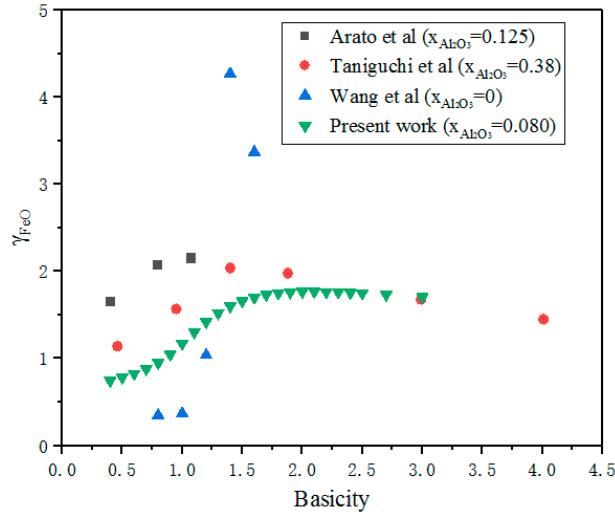
Figure 5. Comparison of present work and reference works.